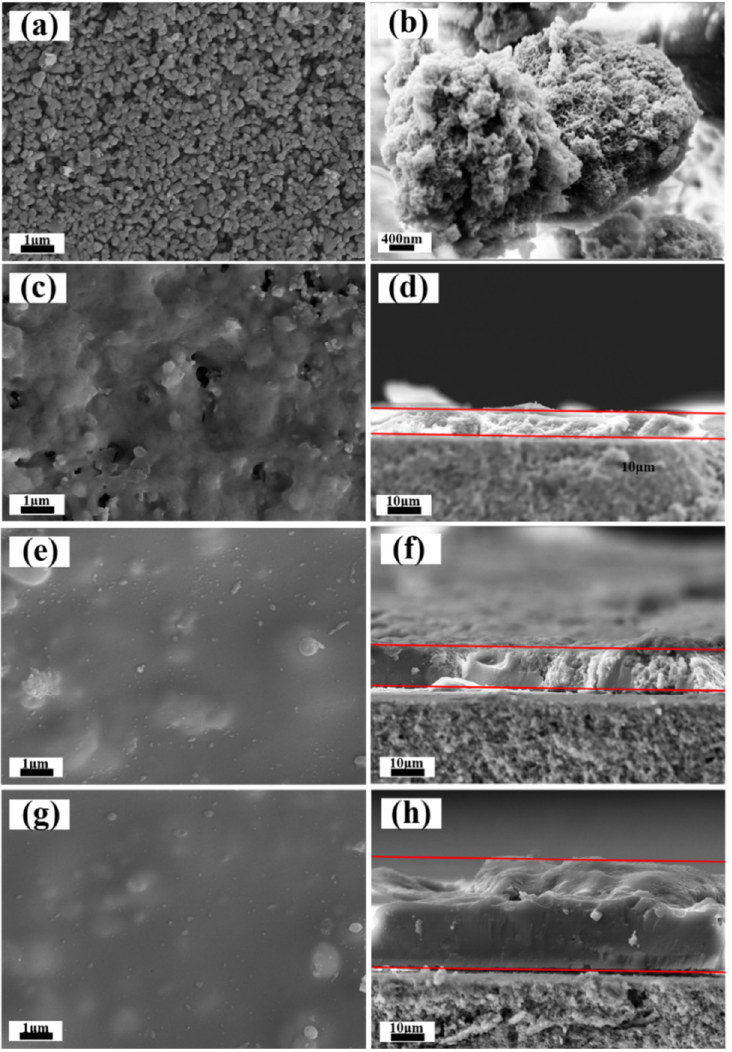
Figure 4. Scanning electron microscopy (SEM) surface morphology of α‐ Al 2 O 3 ceramic membranes ( a ), grinded unsupported MSL ( b ), surface morphology of MSL ‐ 5 ( c ), MSL ‐ 10 ( e ) and MSL ‐ 15 ( g ). SEM cross ‐ sectional morphology of MSL ‐ 5 ( d ), MSL ‐ 10 ( f ) and MSL ‐ 15 ( h ).